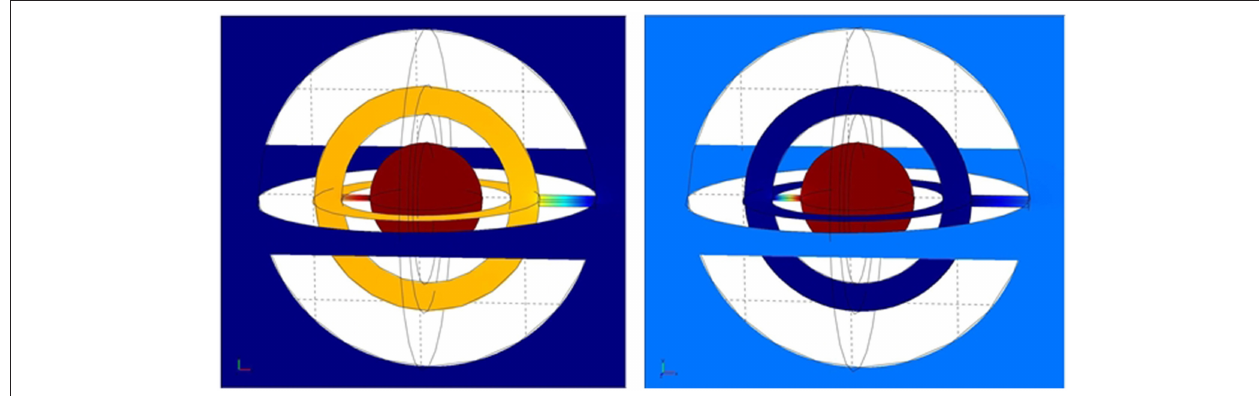
55.2128 rad.s − 1 (left panel) and corresponding to the = 124.2641 rad.s − 1 and =